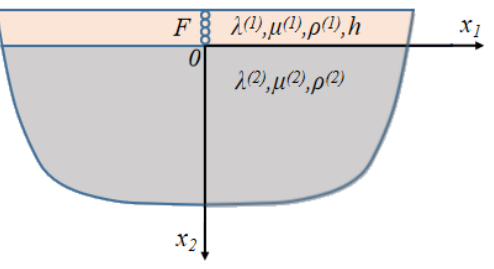
Figure 1. Thin coating structures. Mark (1) and (2) in the upper right corner represent coating and matrix, respectively. A horizontal shear plane wave perturbation is applied to the thin coating, which is written